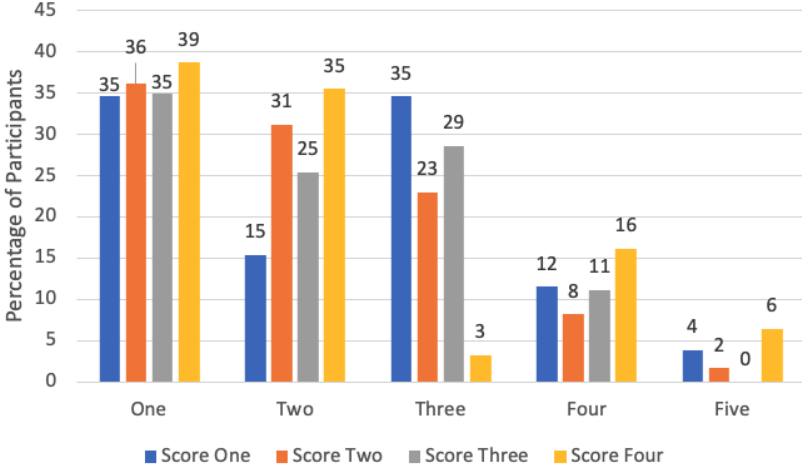
Figure 9. SONA survey: Rating of password “oklahomaStateUniversity” and password strength score. In this figure, the bar charts indicate the password score as measured by zxcvbn. The x-axis indicates the rating a participant gave for this password – 1 is “weak” and 5 is “strong”.